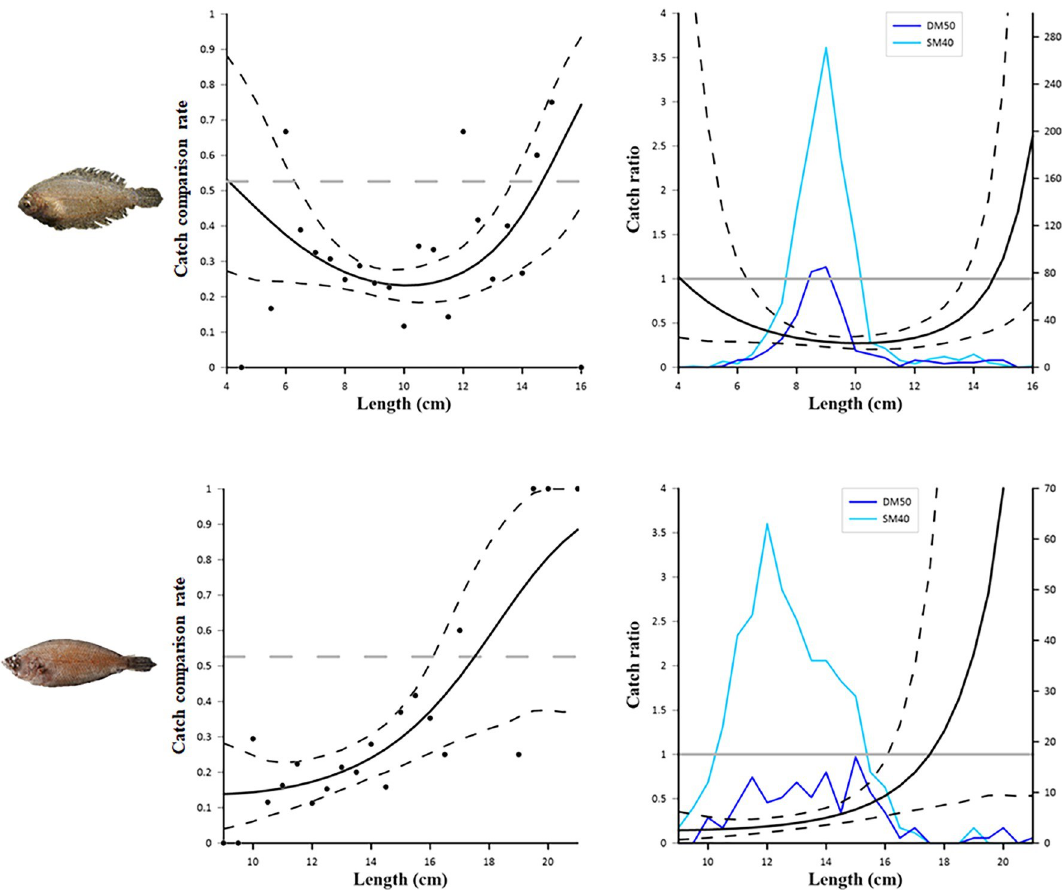
Fig 6. Results of the catch comparison analyses obtained for Arnoglossus laterna (top) and Citharus linguatula (bottom). The graphs on the left show the modelled catch comparison rate (black line) with 95% CI (black stippled curves); the black circles represent the experimental rate; the grey horizontal line at 0.526 represents the point at which both configurations have equal catch rates. The graphs on the right show the catch ratio (black line) with 95% CI (black stippled curves); the blue lines represent the length frequency distributions obtained with the two codends tested (DM50 and SM40); the grey horizontal line at 1.0 represents the point at which both configurations have equal catch rates.